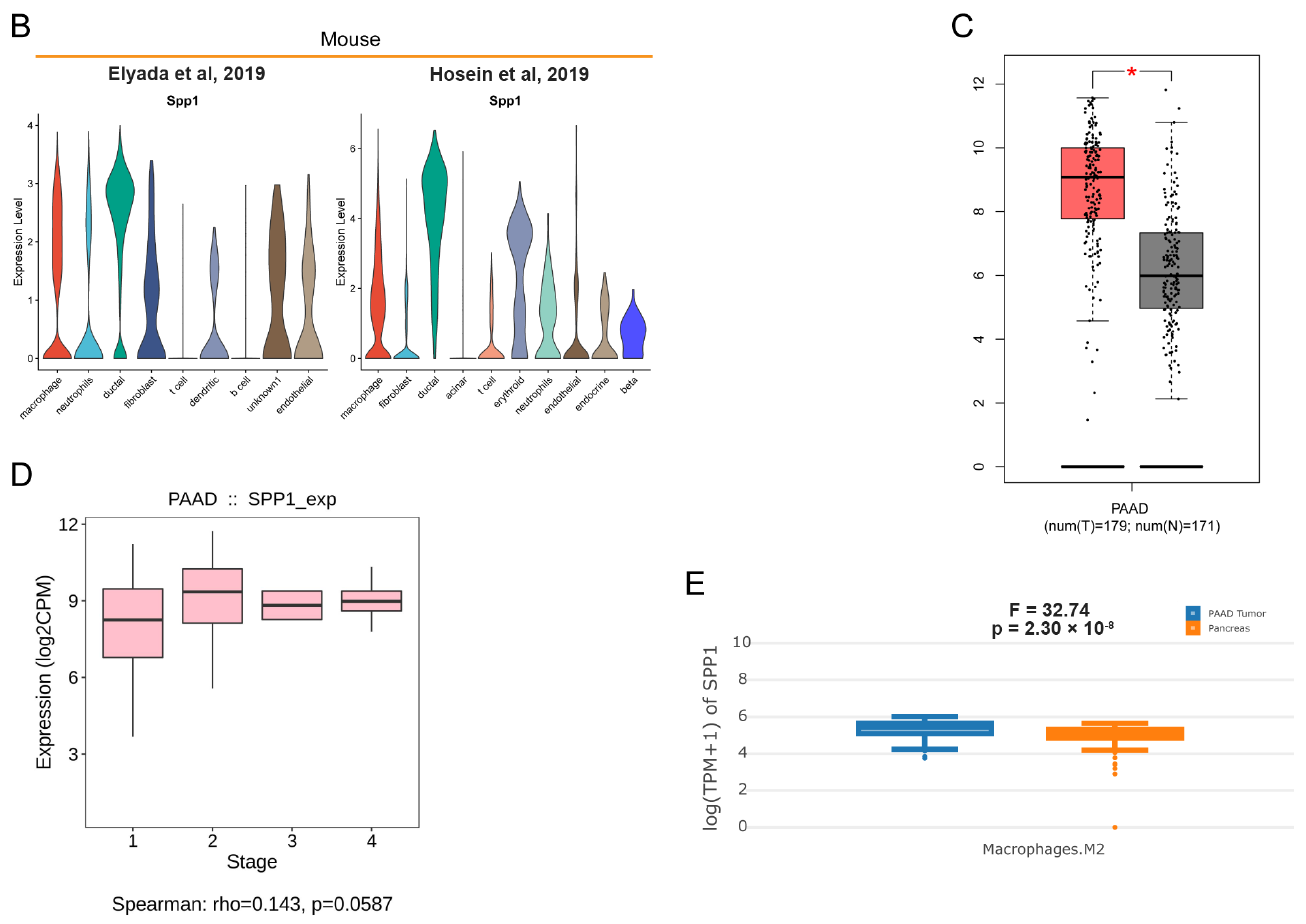
Figure 4. scRNA-seq revealed the distribution of SPP1 in PDAC [9–11,24,25,34]. ( A , B ) Violin plots showing the expression level of SPP1 among distinct cell subpopulations in human and mouse PDAC scRNA-seq datasets; ( C ) the different expression levels of SPP1 in tumor and adjacent normal tissues in TCGA_PAAD and GTEx_pancreas. * represent p < 0.05; ( D ) the expression level of SPP1 among subjects with different stages in TCGA_PAAD; ( E ) M2_macrophage in PDAC had a higher expression of SPP1 than those in normal pancreatic